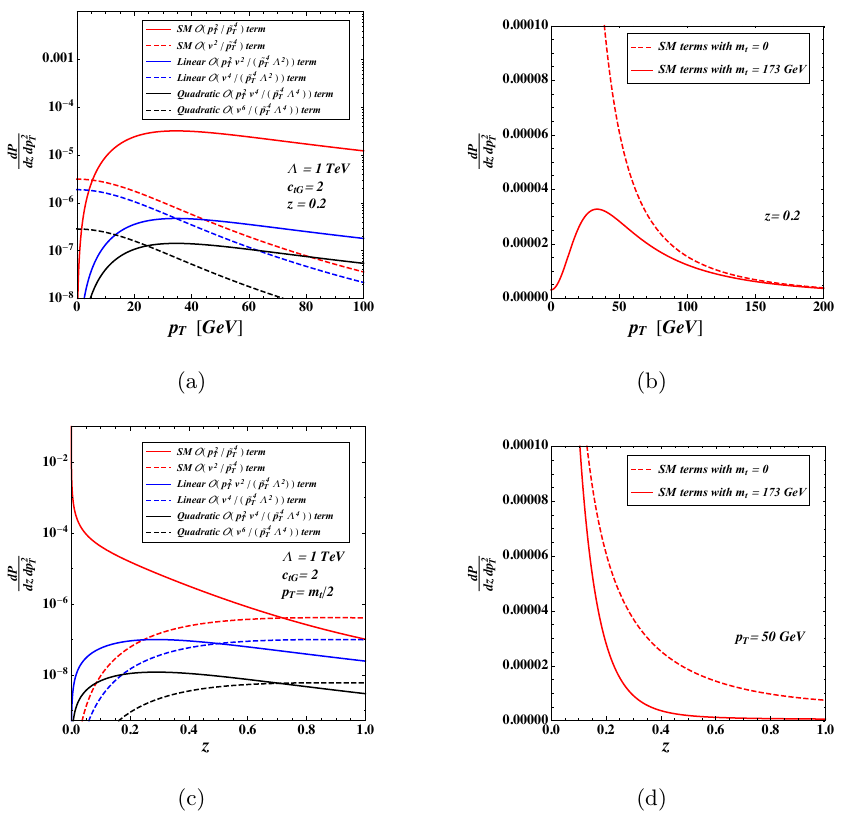
Figure 2 . Splitting functions for the SM, the interference, and the quadratic EFT pieces in eq. (3.4), (3.5), (3.6) respectively. We show the components of each splitting function in terms of (a) p with fixed z = 0 . 2 and (c) z with fixed p = m 2 . To see the mass effect, the SM splitting T T t / function is shown with and without including the mass, in terms of (b) p with fixed z = 0 . 2 and T (d) z with fixed p = 50 T